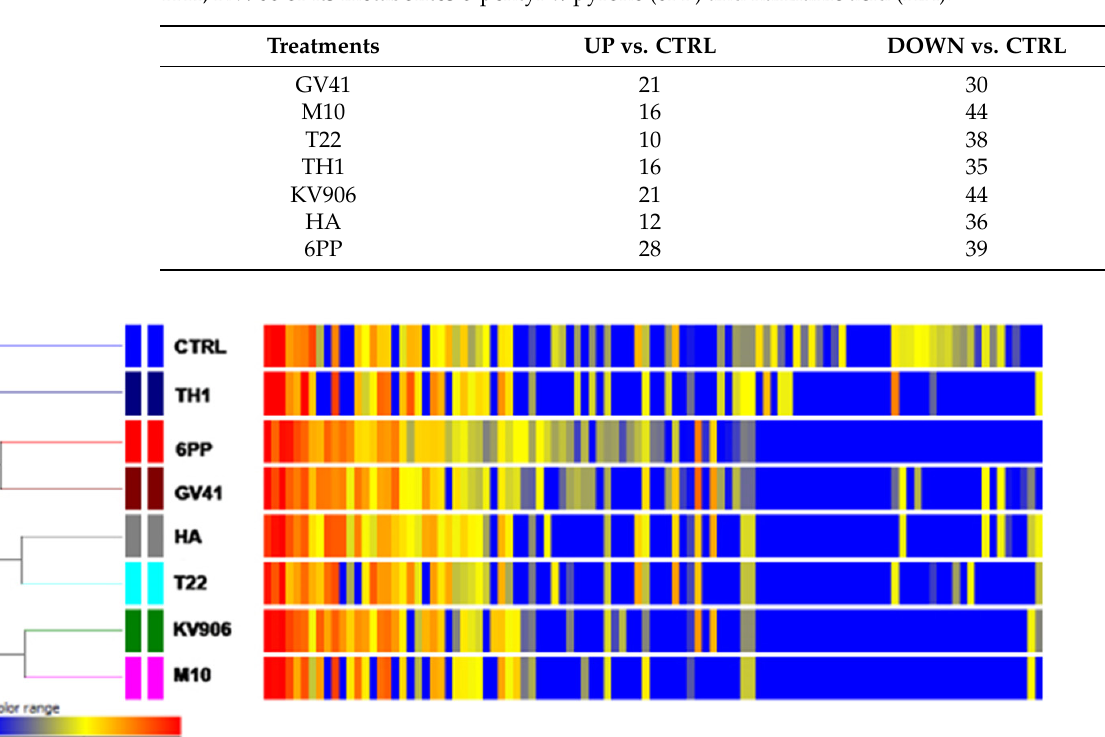
Table 3. Number of metabolites whose production is higher (UP) or lower (DOWN) compared to the control (CTRL) in the drupes obtained from treated plants ( Trichoderma spp. strains T22, M10, GV41, TH1, KV906 or its metabolites 6-pentyl- α -pyrone (6PP) and harzianic acid (HA).